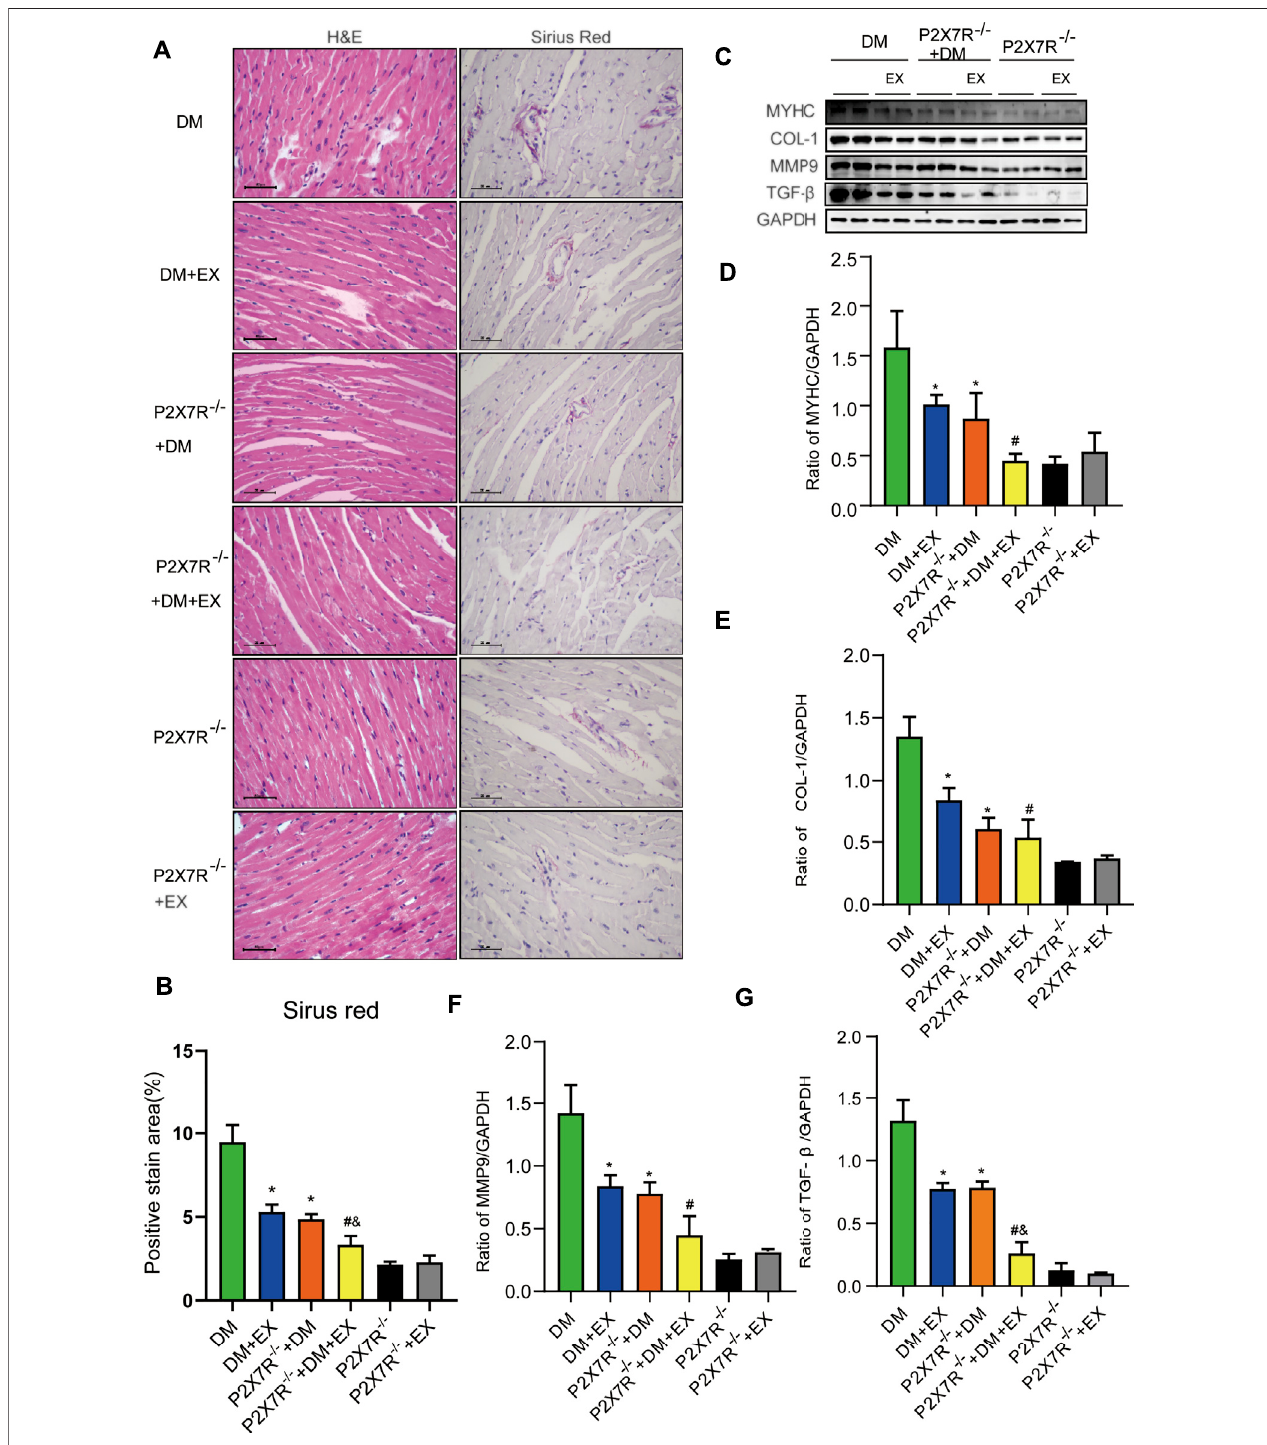
FIGURE 9 | Myocardial remodeling and collagen deposition in the T2DM model of P2X7R knockout mice induced by HFD and STZ injection. (A,B) Hematoxylin – eosin (H&E) and Sirius red staining quantitative statistical images of Sirius red detecting myocardial fi brosis. (C – G) Proteins levels of fi brotic markers (e.g., COL-1, TGF- β , and MMP9) and hypertrophic markers (e.g., MyHC) in myocardial tissues were measured using Western blotting. * p < 0.05 vs. the DM group, # p < 0.05 vs. the DM + EX group.